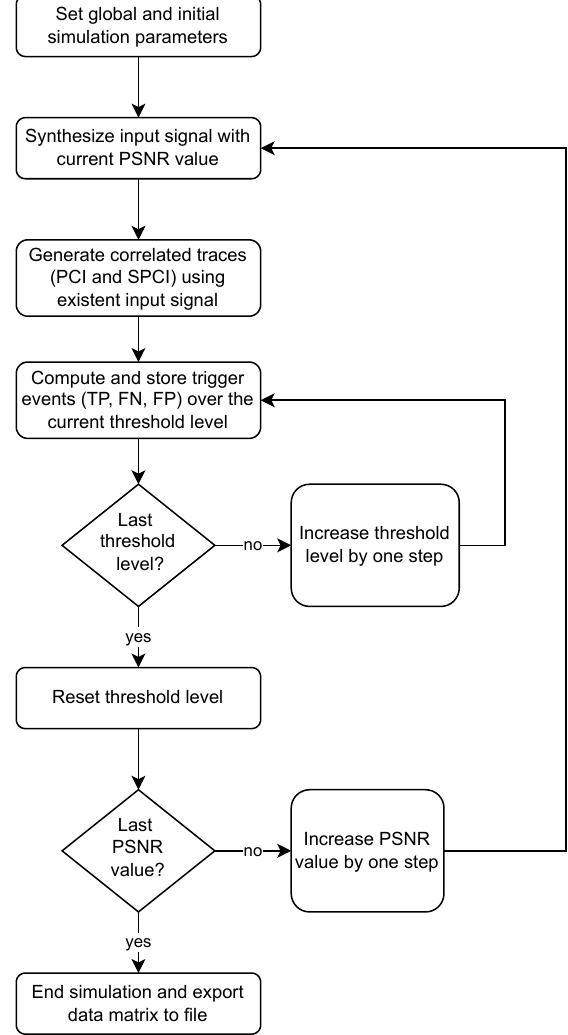
Figure 6. Summarized simulation flow